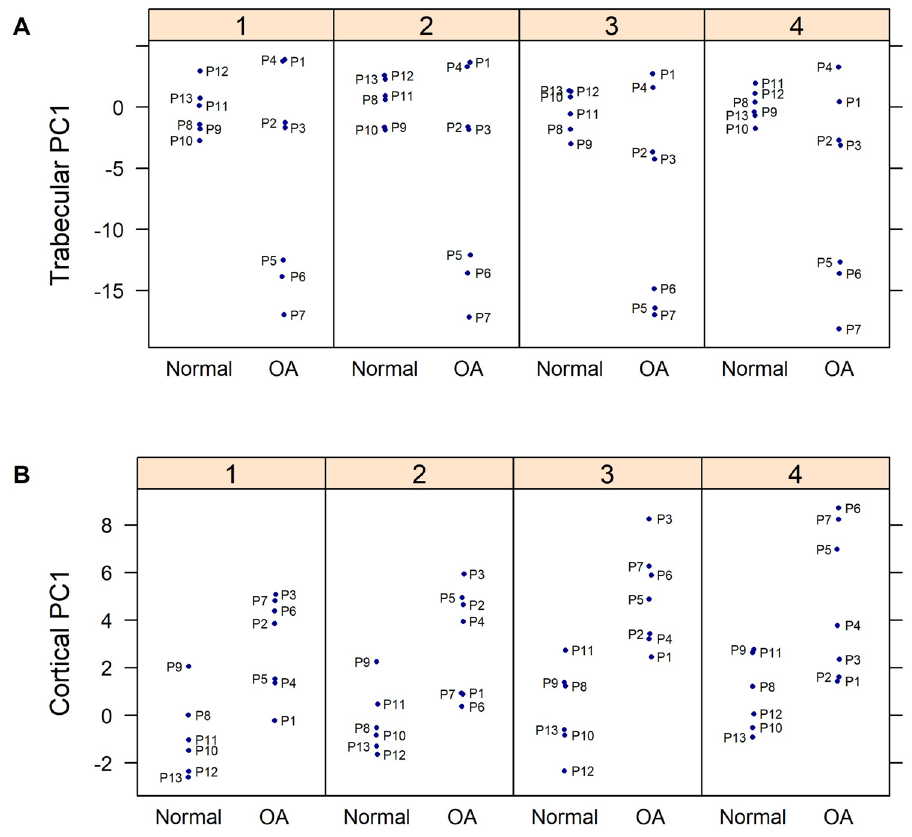
Figure 5. Figure showing principal component (PC 1) between OA and control samples at each quadrant for subchondral ( A ) trabecular and ( B ) cortical